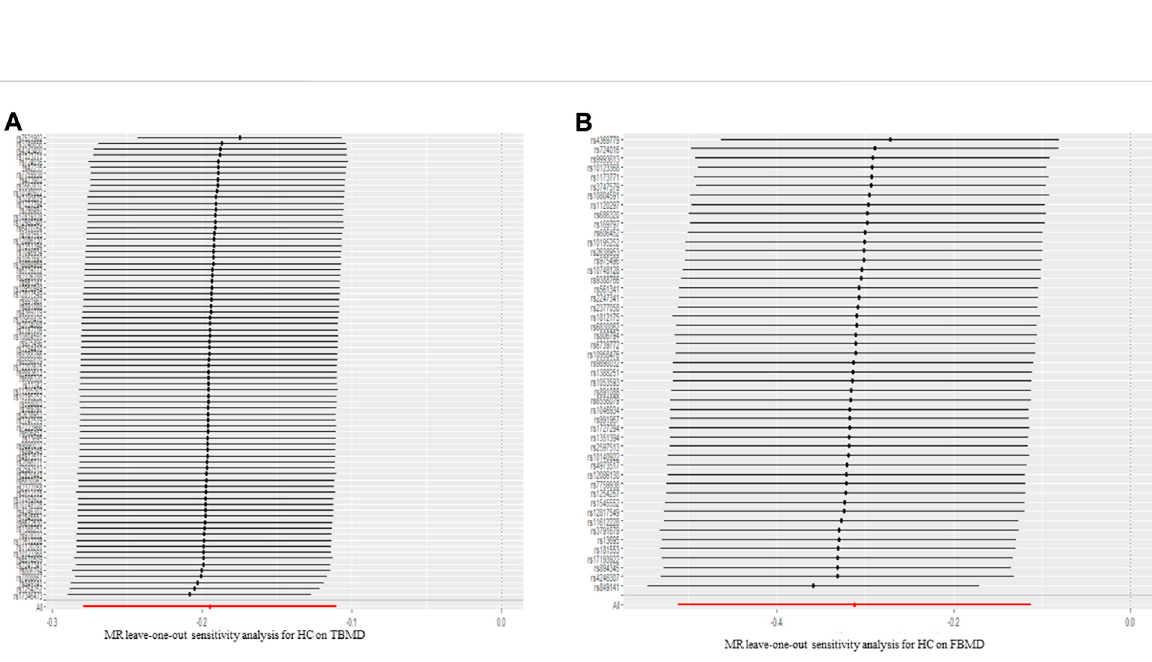
However, heterogeneity (Q = 123.30, p = 1.02 × 10 – 10 ; I 2 = 60.32%) existed in the MR results between HC and TBMD according to Cochran ’ s Q and I 2 statistics. No pleiotropy was found in the causal relationship (intercept = − 0.003, p = 0.168).